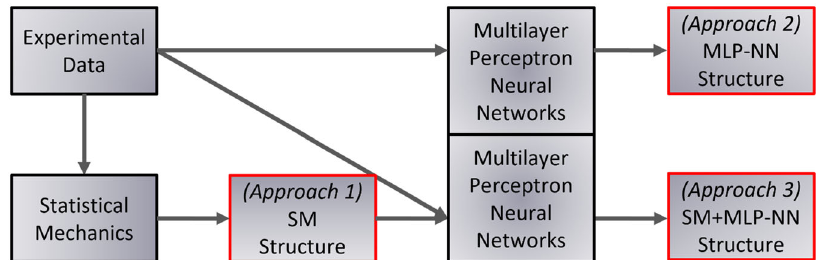
Fig. 1 Flow diagram illustrating the different modeling procedure investigated in this study. The three models, namely statistical mechanics, multilayer perceptron neural networks (MLP-NN), and a combination of the two, are highlighted in red. All three models are trained on the glass composition vs. structure experimental data, while the combined model is trained on both the glass experimental data and the statistical mechanics